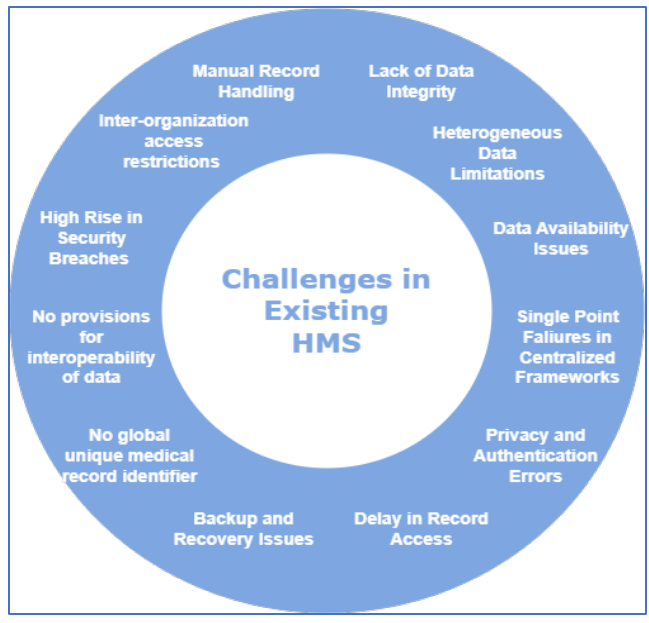
Figure 4. Challenges in the existing HMS [37 – 39].